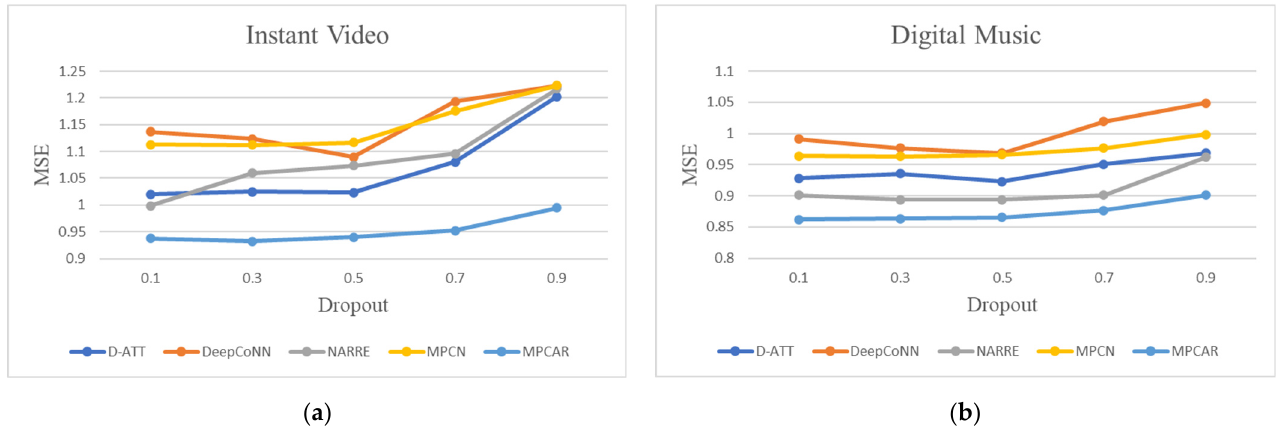
Figure 3. ( a ) Effect of the dropout rate on model performance (Instant Video); ( b ) Effect of the dropout rate on model performance (Digital Music).